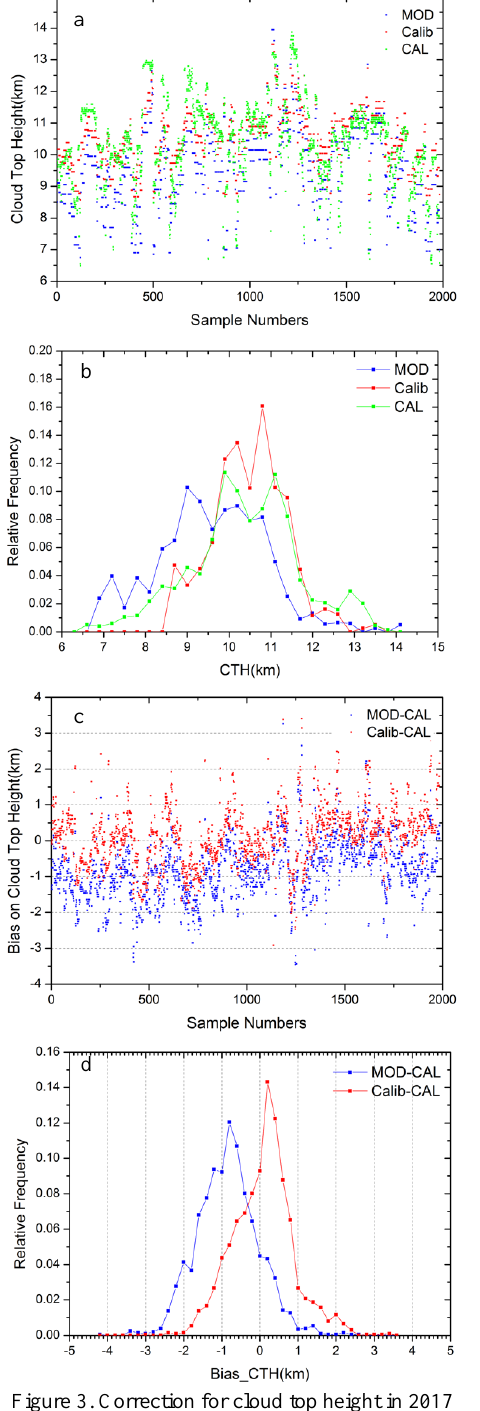
Figure 3. Correction for cloud top height in 2017 (a and b represent scatter distribution and probability distribution of cloud top height for raw MODIS (blue), corrected MODIS (red) and CALIPSO (green). c and d represent scatter distribution and probability distribution for